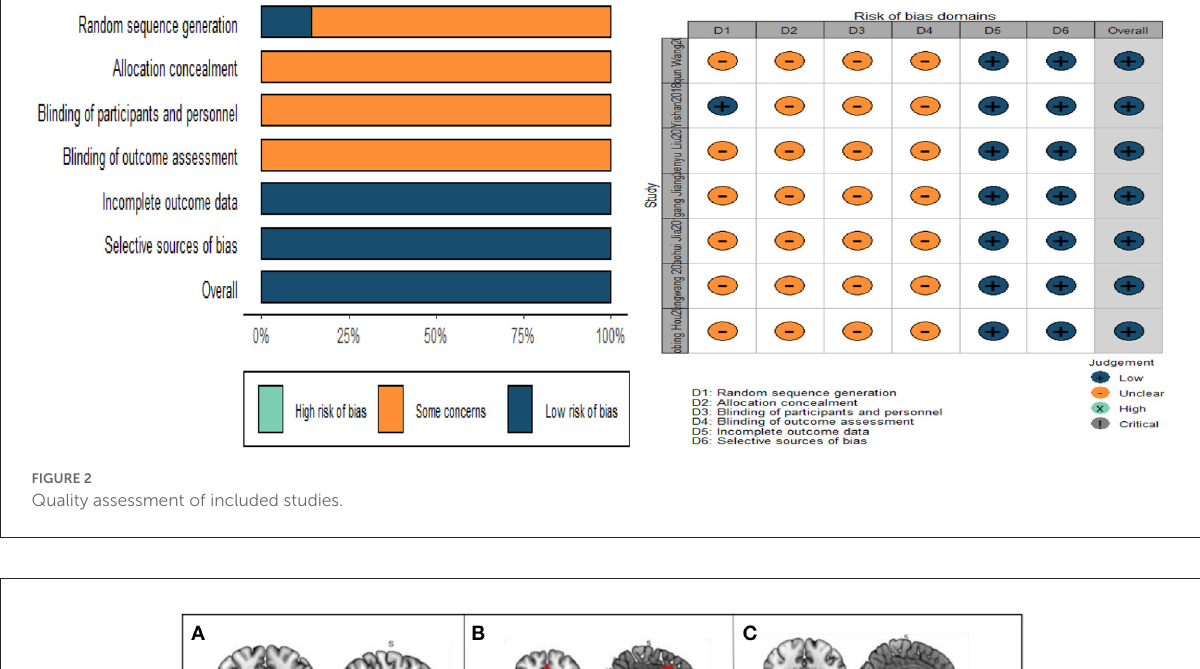
FIGURE2 Quality assessment of included studies.